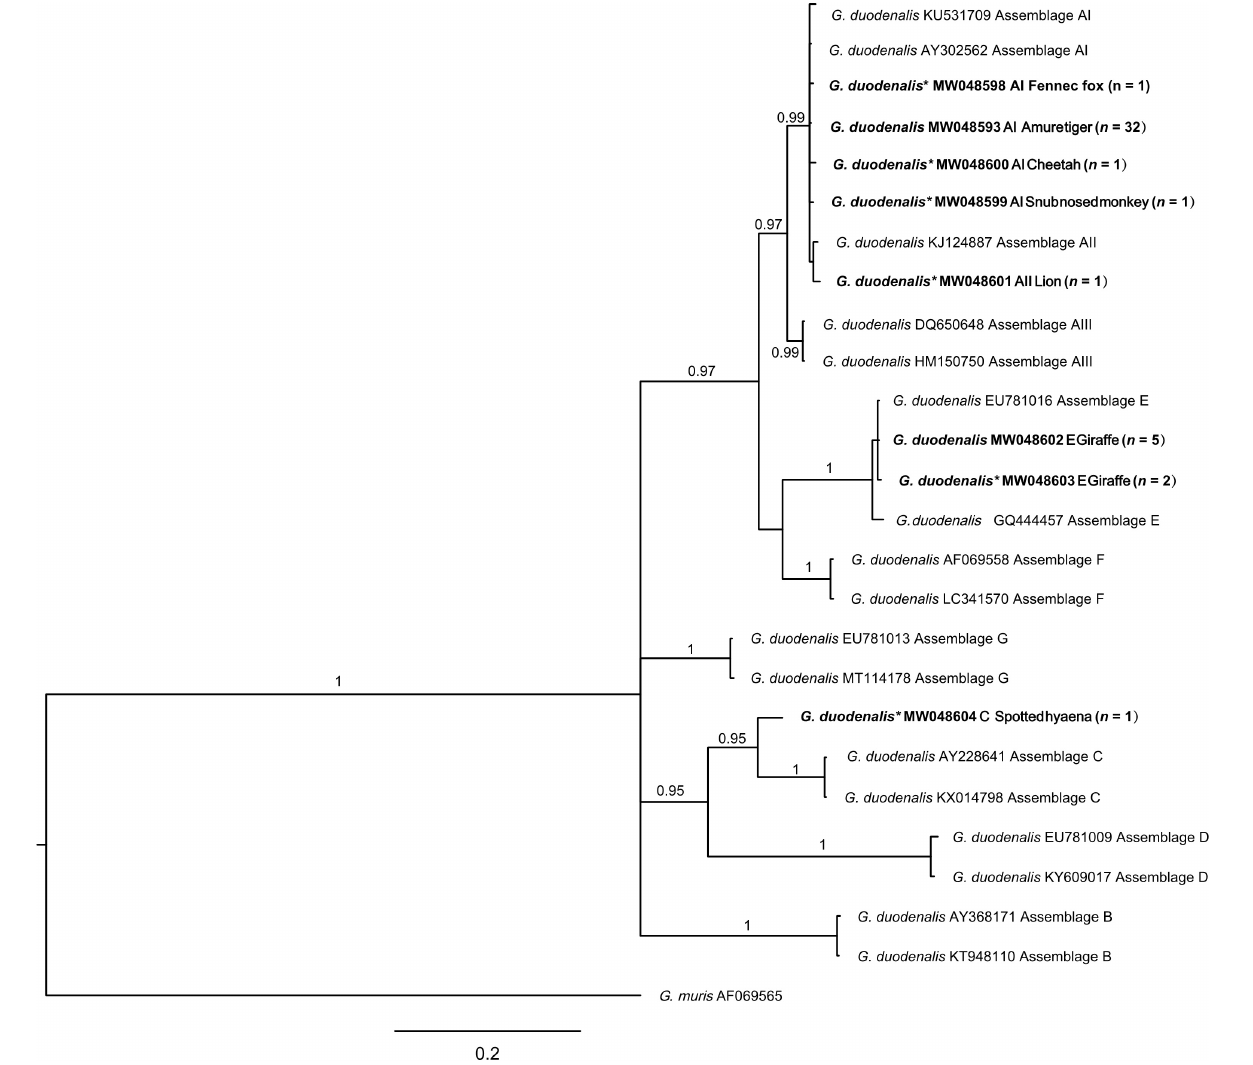
FIGURE 3 | Relationships among Giardia taxa inferred from the phylogenetic analysis of partial triose-phosphate isomerase gene ( tpi ) sequence data by Bayesian inference (BI). Posterior probabilities are indicated at all major nodes. Bold font indicates Giardia species or genotypes characterized from fecal DNA samples in this study. In parentheses are the numbers of samples representing a particular species, genotype, and sequence (GenBank accession numbers indicated). Novel genotypes (*). Scale bar represents the number of substitutions per site. All groups were strongly supported ( pp = 0.96–1.00). pp < 0.95 were not